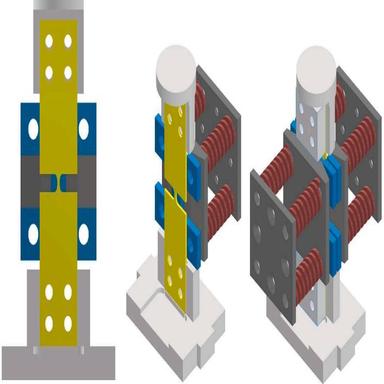
Anti T-buckling device combined to a specimen.